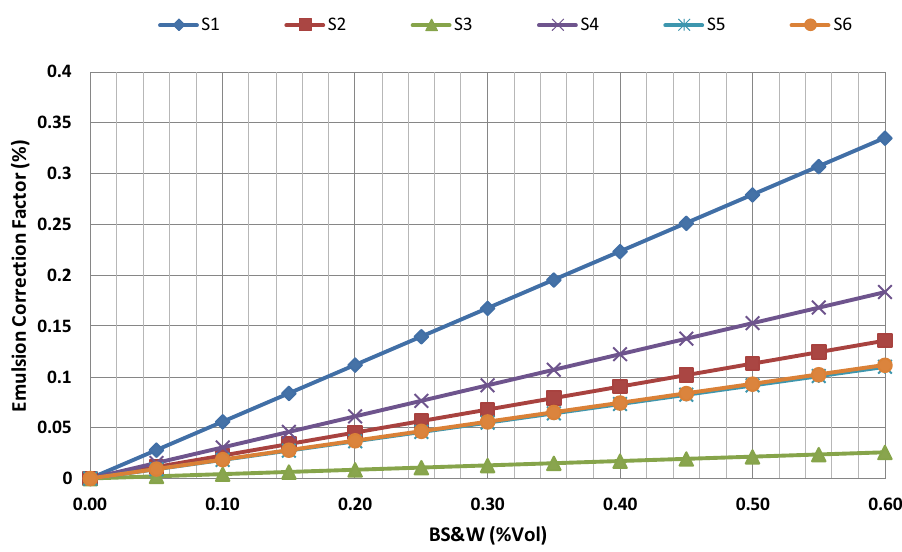
Fig. 6 Sensitivity BS&W against ECF